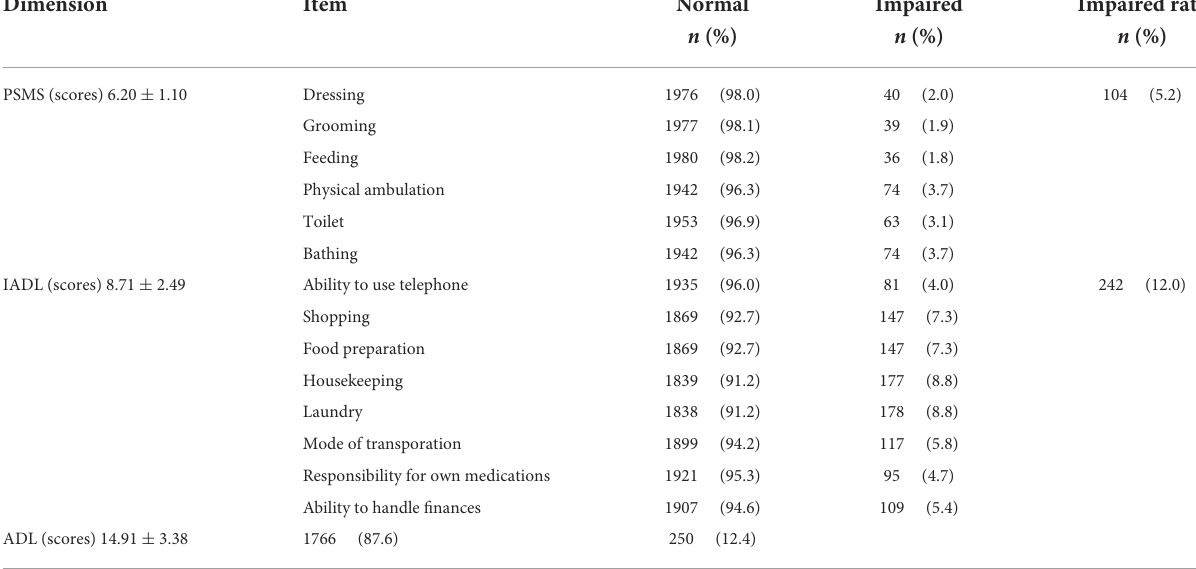
TABLE 1 Functional limitation in older people with type 2 diabetes in Fuzhou City. Dimension Item Normal